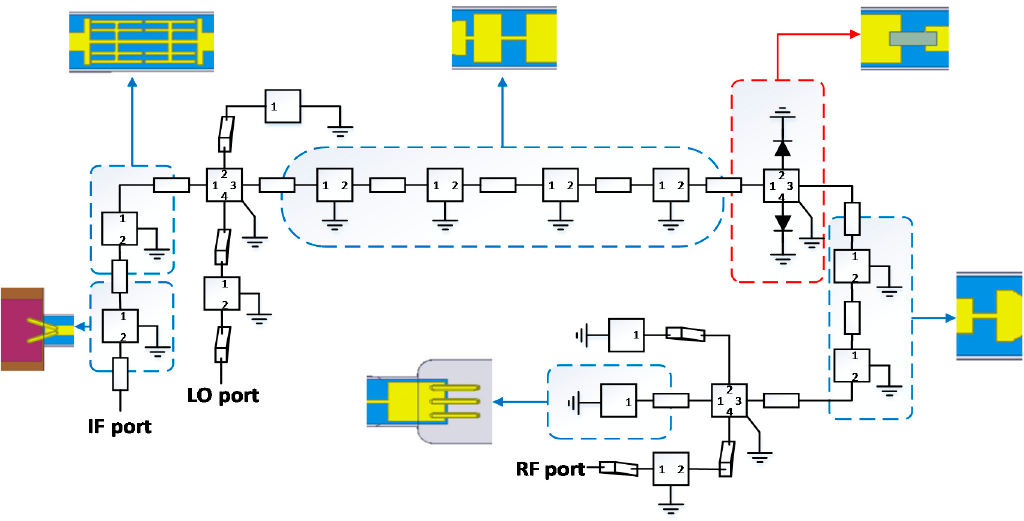
Figure 6. The circuit simulation schematic in the ADS.